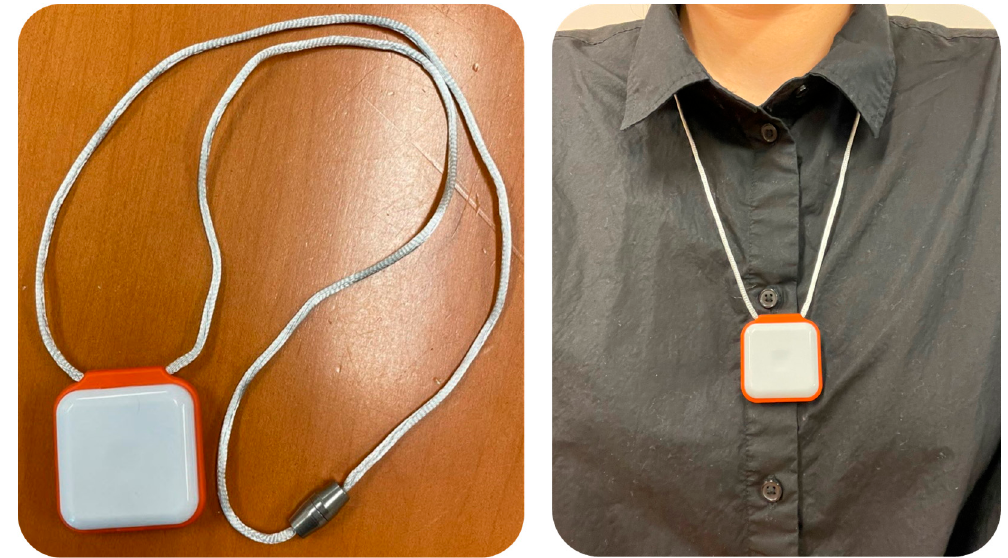
Figure 1. The PAMSys wearable sensor and its placement. Table 1. Description of 12 sensor-derived features and associated